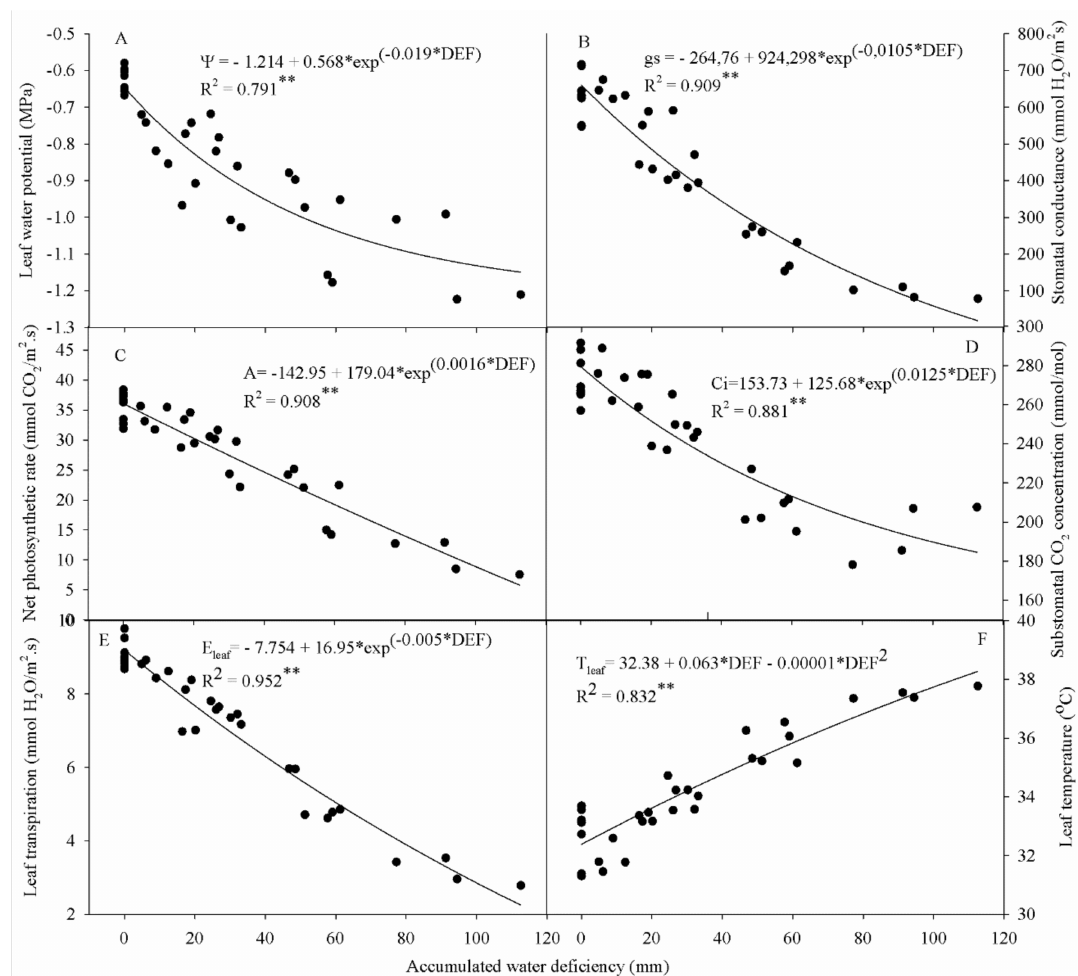
Figure 4. Leaf water potential— Ψ w ( A ), stomatal conductance— gs ( B ), net photosynthetic rate— A ( C ), substomatal CO 2 concentration— Ci ( D ), leaf transpiration— E leaf ( E ) and leaf temperature— T leaf ( F ) of cowpea plants during the reproductive phase according to accumulated soil water deficiency in the 2015 and 2016 experiments, Castanhal, Par á . ** Significant by the F test ( p ≤